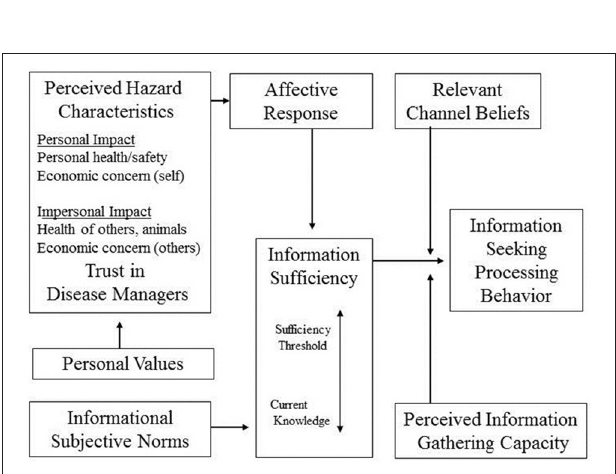
FIGURE 2 | Clarke’s RISP framework for zoonotic diseases [adapted from